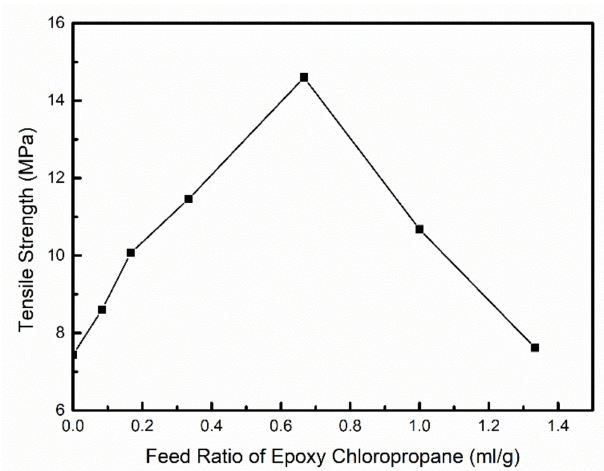
Figure 8. E ff ect of epoxy chloropropane feed ratio on the tensile strength of hemicellulose films.